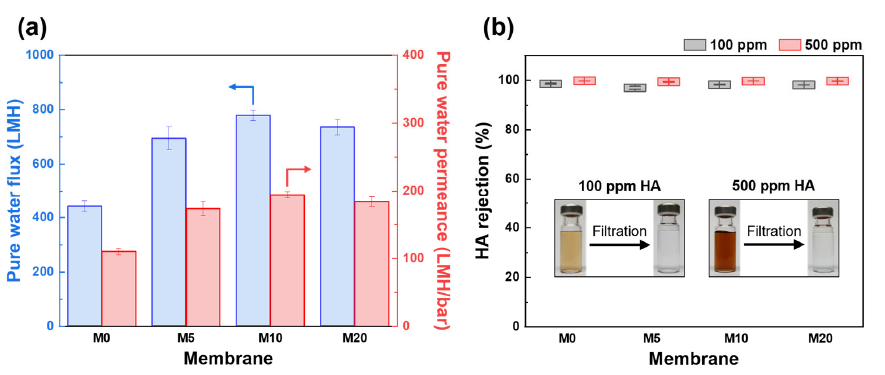
Figure 6. Filtration performance of PES and FCNT/PES nanocomposite HF membranes. ( a ) Pure water flux (blue) and permeance (red). ( b ) HA rejection.